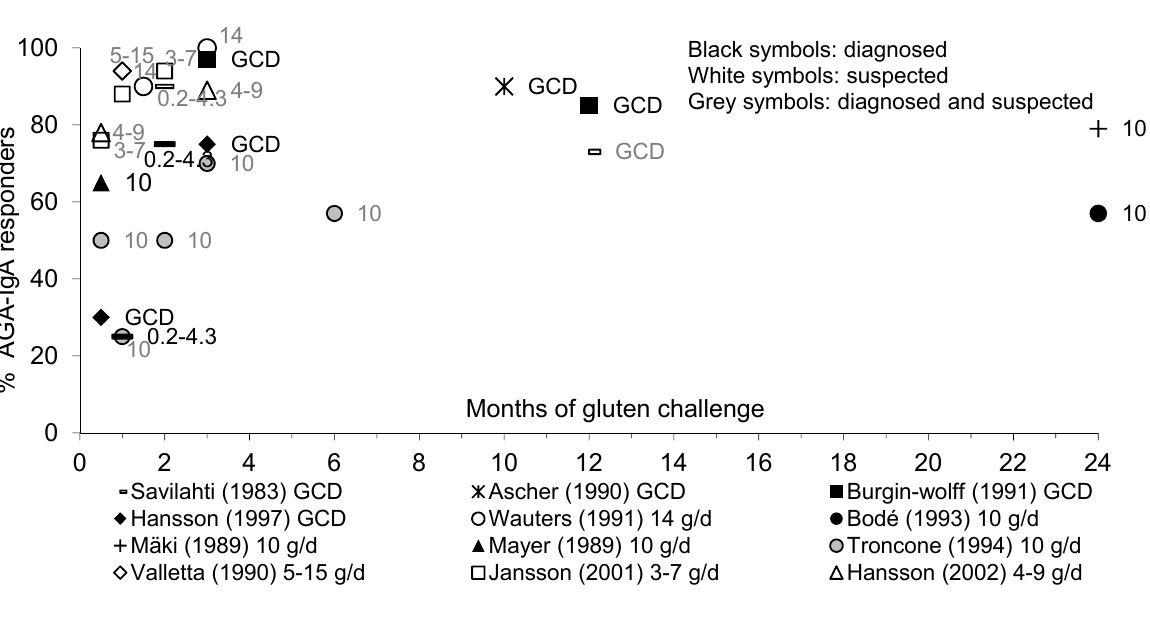
Figure 1. Percentage of pediatric patients with diagnosed or suspected coeliac disease (CD) showing an anti-gliadin antibodies (AGA)-IgA response to gluten over time.